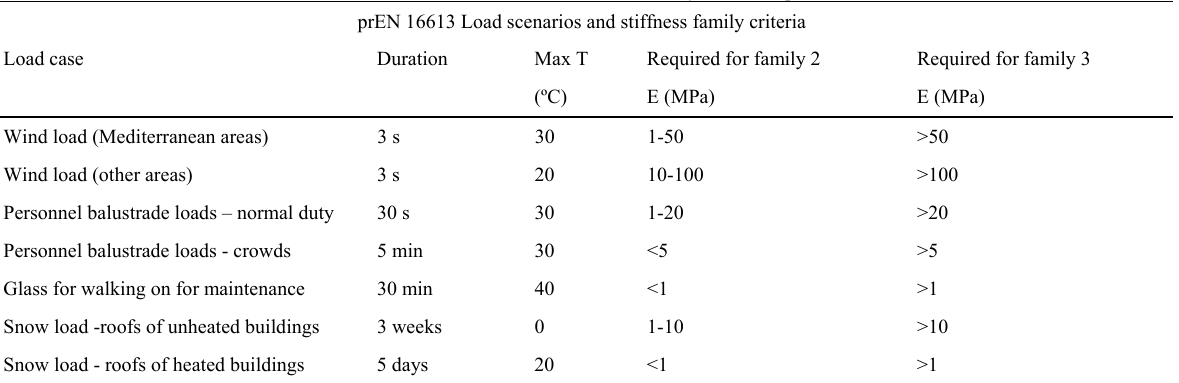
Table 4: Load scenario’s and stiffness family criteria in prEN 16613